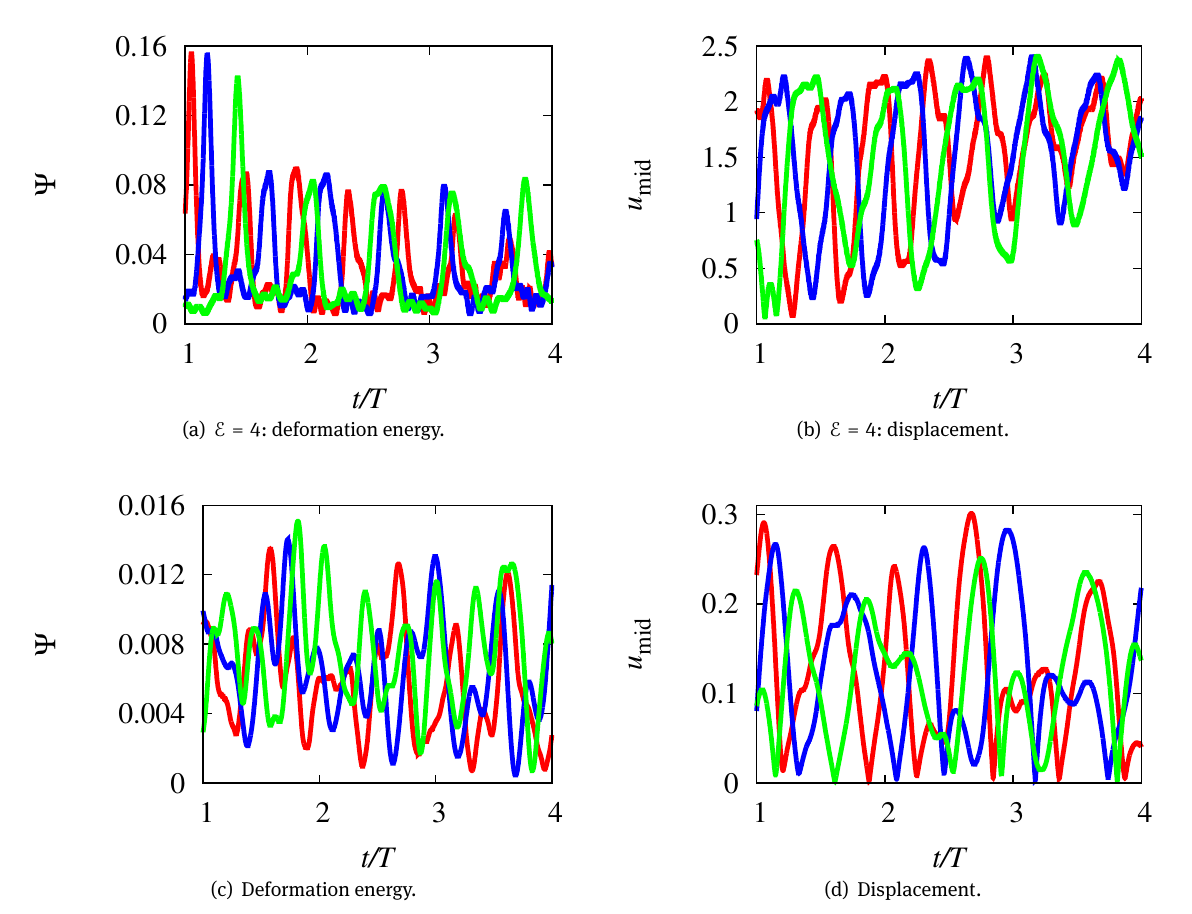
Figure 7: Time history of the deformation energies for different values of R at D = 7.8 (red curve), D = 10 (blue curve) and D = 15 (green curve). All the simulations are characterized by R = 100 and E = 200